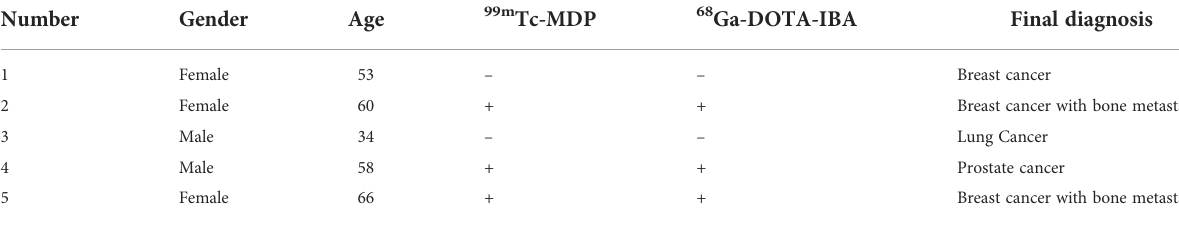
TABLE 3 Summary of the basic patient information and clinical diagnosis for 99m Tc-MDP imaging results with 68